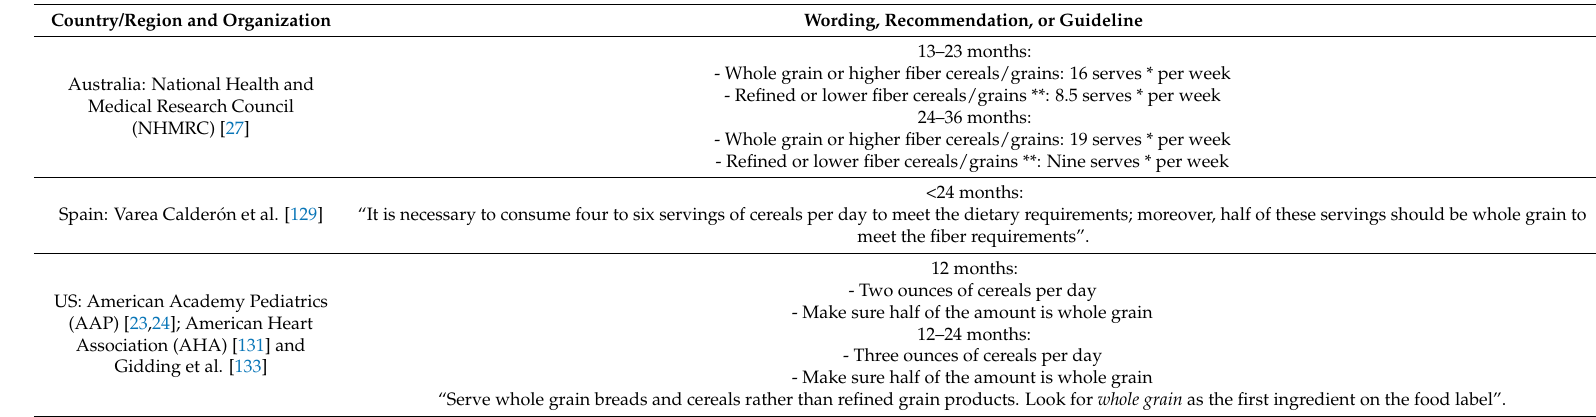
Table 3. Examples of whole grain recommendations for infants and young